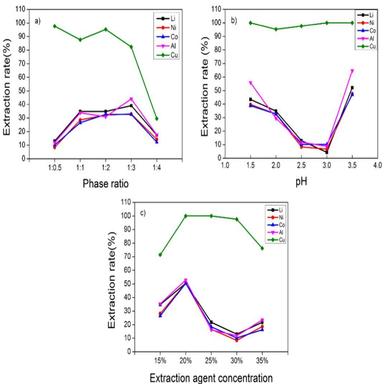
Copper ion removal curves: (a) phase ratio, (b) pH and (c) extraction agent concentration.